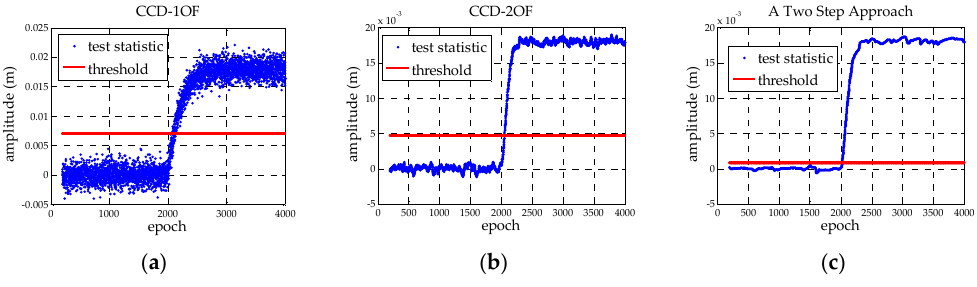
Figure 5. ( a – c ) Sample anomaly detection by CCD-1OF, CCD-2OF and TSA, respectively.